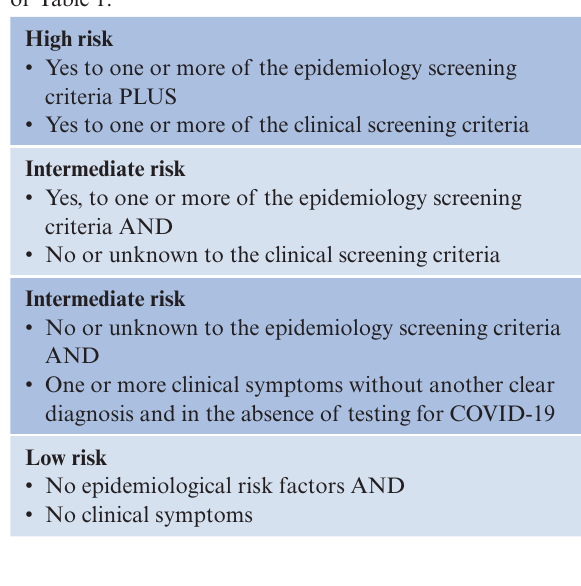
Table 3. Donor classification for donor-derived COVID-19 based on clinical symptoms and epidemiological screening of Table